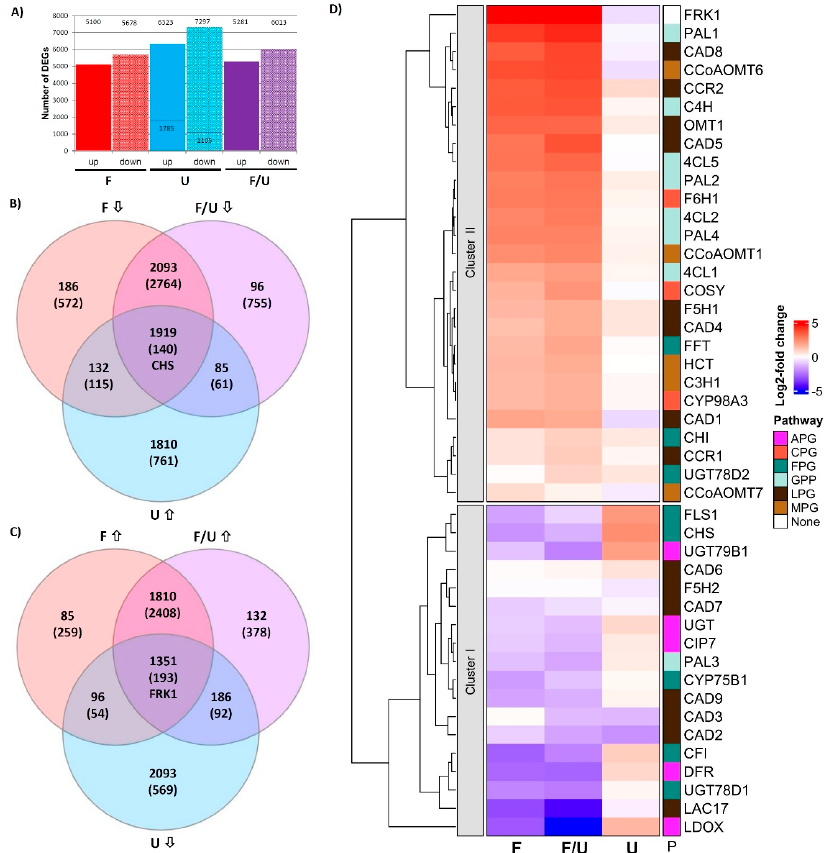
Figure 1. Impact of crosstalk on transcriptomic changes in Arabidopsis. ( A ) An overview of DEGs identified from RNAseq experiments using pooled RNA of three independent biological replicates. Treatments with flg22 (F), UV-B (U), or co-treatment with flg22 and UV-B (F/U) as compared to the control. DEGs were identified by applying a log2 threshold ≤ − 1 or ≥ 1 for each treatment. Since we detected approximately five-fold fewer DEGs in the UV-B samples we lowered the log2 threshold to ±0.2 for this treatment in order to obtain a comparable number of DEGs as in the other treatments. ( B ) A Venn diagram displaying the number and distribution of DEGs that were down-regulated in response to single and co-treatment flg22, but up-regulated by UV-B (CHS-group). ( C ) A Venn diagram displaying the number and distribution of DEGs that were up-regulated in response to single and co-treatment with flg22, but down-regulated by UV-B (FRK1-group). The DEG numbers shown in ( B , C ) are based on a log2 threshold ≤ − 1 or ≥ 1 for flg22 or F/U co-treatment with the log2 threshold for the UV-B treatment lowered to ± 0.2. ( D ) Cluster analysis of genes involved in phenylpropanoid metabolism shows the expected expression patterns with genes involved in the flavonoid pathway (FPG and anthocyanin biosynthesis-related genes) being largely up-regulated by UV-B and suppressed in response to flg22 and containing the CHS marker gene (Cluster I) as well as genes being up-regulated in response to flg22 (Cluster II), belonging to the general phenylpropanoid (GPP), monolignol (MPG), lignin (LPG) or coumarin (CPG) pathways clustering together with the FRK1 marker gene for successful induction of pattern triggered immunity (PTI). Expression levels are calculated based on log2-fold changes relative to the untreated control. Gene name abbreviations and concrete log2 values underlying the calculation can be found in Table